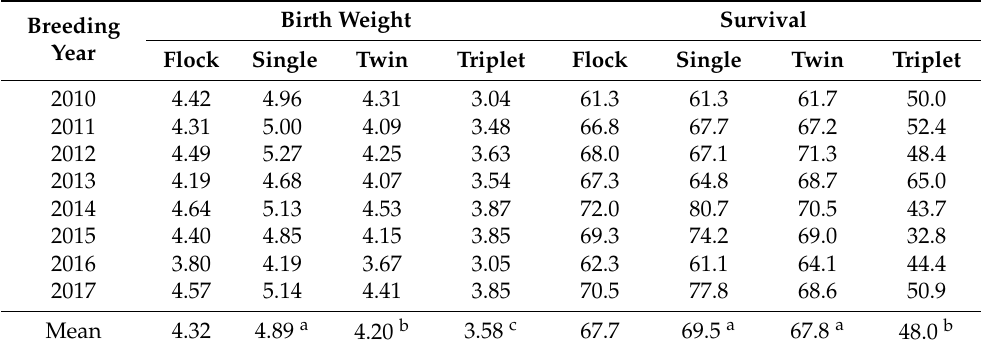
Different superscripts differ ( p < 0.05) between offspring from ewe lambs born as singles, twins or triplets and comparisons only apply to the overall averages across the eight years.